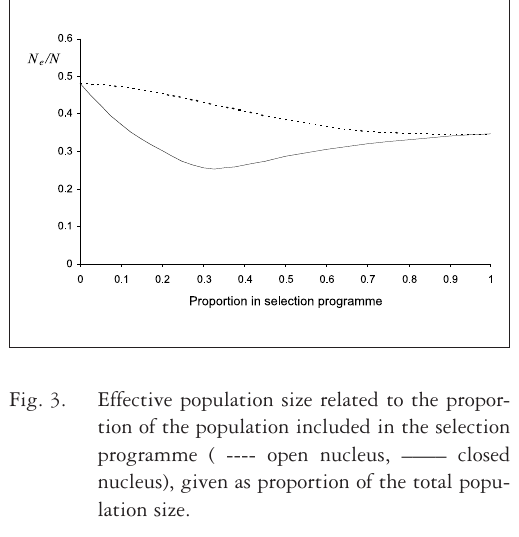
Fig. 3. Effective population size related to the propor- tion of the population included in the selection programme ( ---- open nucleus, ____ closed nucleus), given as proportion of the total popu- lation size.